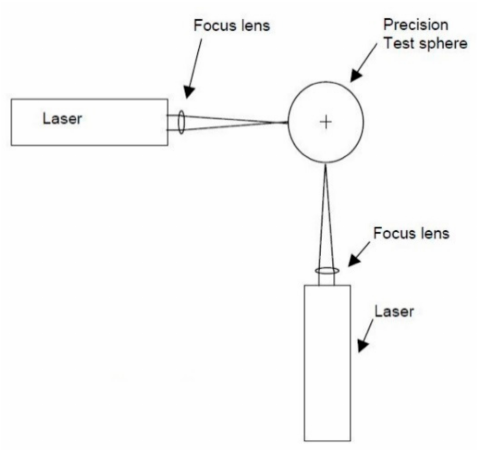
Figure 16. Diagram of the laser system and the ball standard